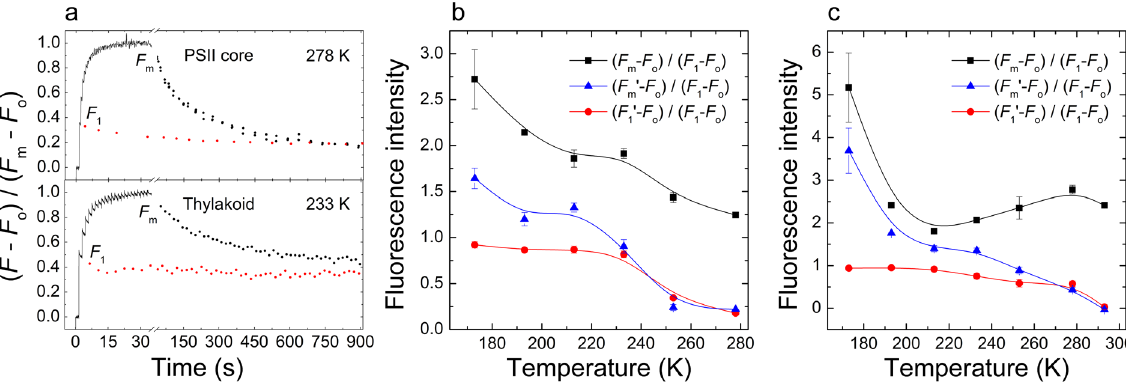
Figure 1. Temperature dependence of chlorophyll- a fluorescence induction. Kinetic traces at different temperatures ( a ) and parameters of STSF-induced fluorescence transients as a function of temperature in isolated spinach thylakoid membranes ( b ) and in isolated PSII core complexes of T . vulcanu s ( c ). In panel a, red and black data points belong to transients induced by a single STSF and a train of STSFs, respectively. F m ′ and F 1 ′ denote the corresponding fluorescence levels measured after 15 min in the dark following the excitation(s), and thus the black, blue and red curves represent the temperature dependences of F m , F m ′ and F 1 ′ , respectively, normalized to F 1 . In panel a, the decay kinetics of F 1 and F m levels were measured on separate samples. In all cases when measuring the decay kinetics, in order to avoid its actinic effect, the measuring beam was turned on and off